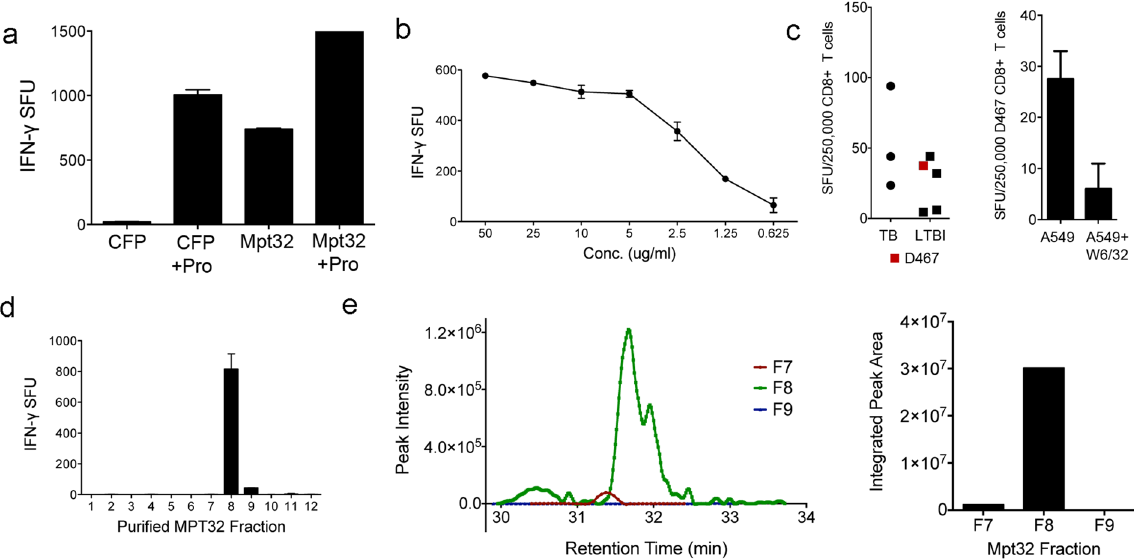
Figure 2. The amino terminus of native MPT32 contains the HLA-E epitope. ( a , b ) DC were pulsed with the following samples and used as antigen presenting cells in an ELISPOT assay with IFN- γ release (spot forming units (SFU)) by the HLA-E restricted T cell clone, D160 1–23, as a readout. ( a ) Culture filtrate protein (CFP) or native Mpt32 left untreated or pronase-digested. ( b ) A titration of pronase-digested native Mpt32. ( c ) Autologous DC were pulsed with pronase-digested MPT32 and used as antigen presenting cells in ELISPOT assay with IFN- γ release (spot forming units (SFU)) by purified CD8 + T cells from Mtb infected or latently infected donors (left). The pan Class I blocking antibody W6/32 was incubated with A549 cells for 1 hour prior to addition of MPT32. ELISPOT with purified CD8 + T cells from D467 was performed as described for DC (right). ( d ) DC were pulsed with RP-HPLC fractions of native Mpt32 and used as antigen presenting cells in an ELISPOT assay with IFN- γ release (spot forming units (SFU)) by the HLA-E restricted T cell clone, D160 1–23, as a readout. ( e ) The unique peptide signal in F8 of pronase-digested Mpt32 corresponds to pronase digestion product and putatitive N-terminal glycopeptide (n-APPAPAP[162.1]PVAPPPPAAA-c) observed as a double charged mass of 827.84 Da. Additional peptides and masses are listed in Supplemental Table 2.